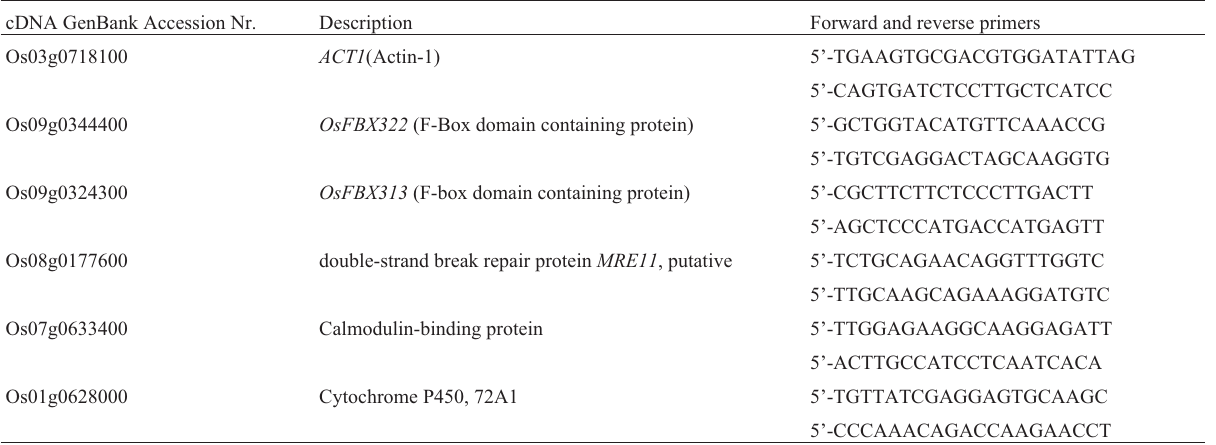
Table 1 - Primer and probe sequences used for real-time RT-PCR. cDNA GenBank Accession